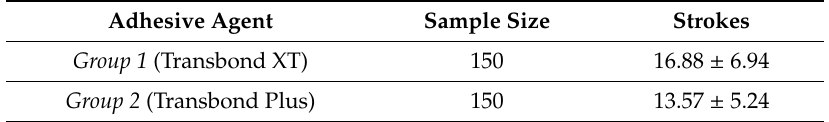
Table 6. Comparison of the mean frequency of shearing strokes of the groups with adhesive